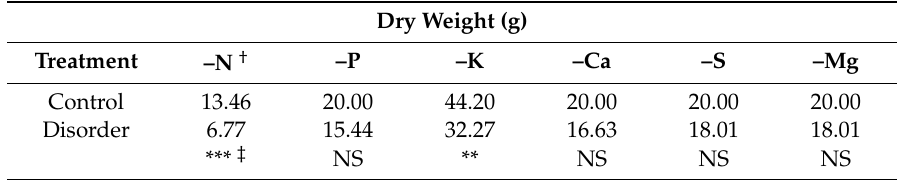
Figure 1. Sketch of a branch of Cannabis sativa ‘T1’ plant showing plant anatomy and terminology. Table 1. Mean dry weights of Cannabis sativa ‘T1’ plants grown with a deficient macronutrient treatment compared to plants grown with a complete fertilizer.